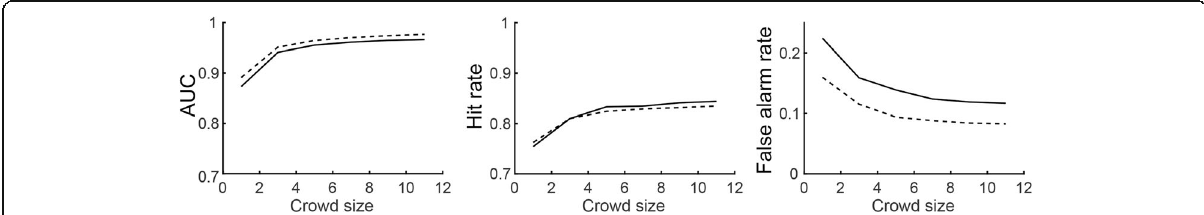
Fig. 4 Results of Analysis 3 showing average team performance on FR-Task in session two as a function of the number of individual responses aggregated. The solid line shows teams selected from the whole pool of participants and the dashed line shows teams selected from individuals achieving an average score of above one standard deviation on the session-one face tests. For comparison, crowd size of 1 is included, representing average performance of individuals. Details are provided in the main text. AUC area under the